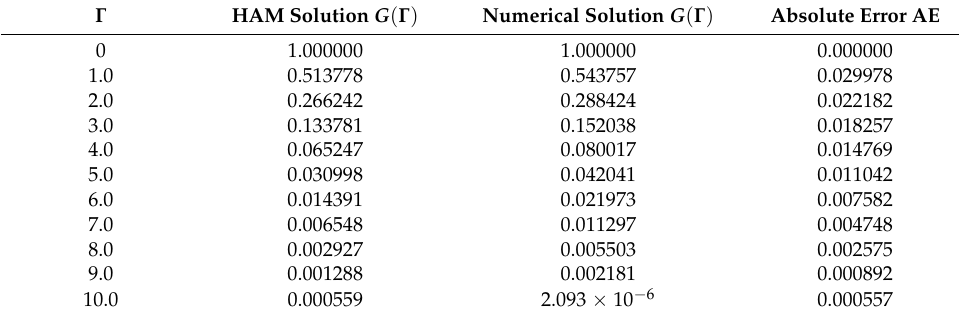
Table 4. The association between HAM and numerical solution for G ( Γ ) , when K = 0, A = 0.2, κ